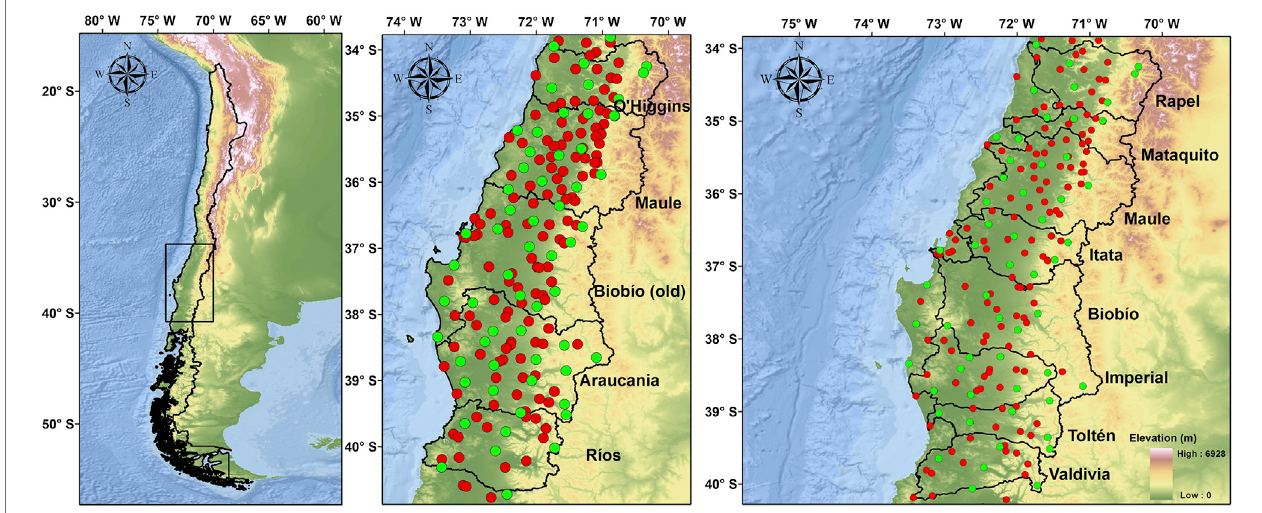
FIGURE 1 | (A) Study area in central-southern Chile (O ’ Higgins – Los Ríos). (B) River basins used for spatial yield analysis of the weather research and forecasting model, thegriddedprecipitationsets( Table 2 ),and thetopo-climatic model. Thered dotsindicatethe136stations used asinputforthetopo-climaticmodeland the60 green dots indicate the stations used for performance analysis.